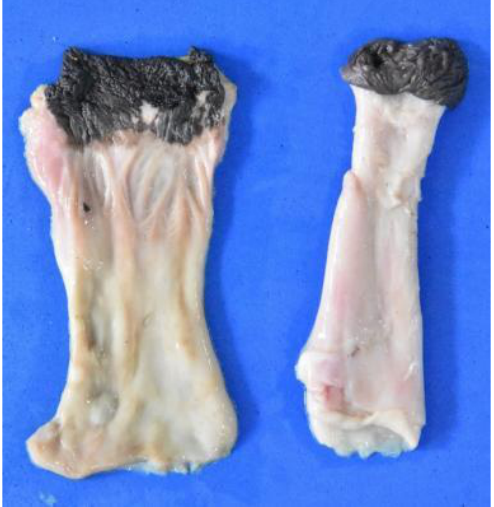
Figure 22. Image of two rectum of different specimens (the one on the left is opened).